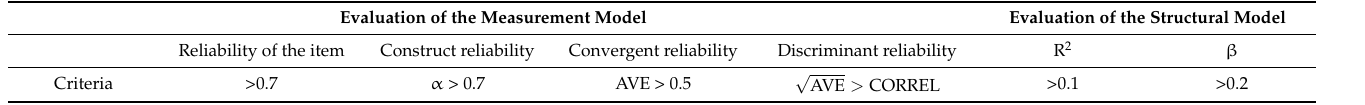
Table 3. Model evaluation parameters according to the